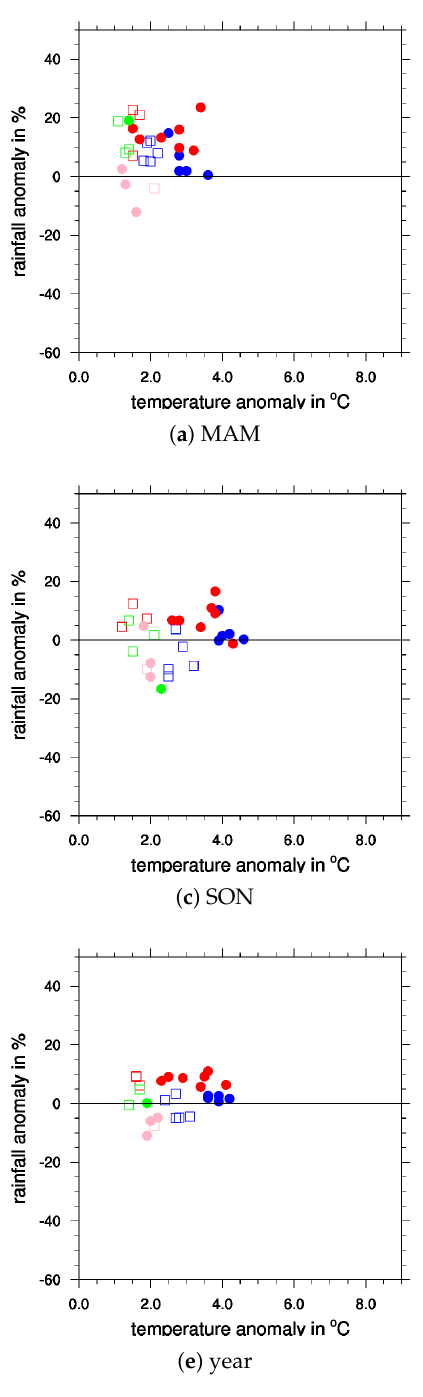
Figure 7. Comparison of EPISODES downscaling results based on RCP4.5 (CMIP5) and SSP2-4.5 (CMIP6) for Germany. The symbols (open: CMIP5; filled: CMIP6) show the Germany-wide mean climate change signal in annual/seasonal precipitation and temperature for 2071–2100 with respect to 1971–2000. Different colours correspond to different GCMs. (Seasons: ( a ) spring (MAM), ( b ) summer (JJA), ( c ) autumn (SON), ( d ) winter (DFJ), and ( e )